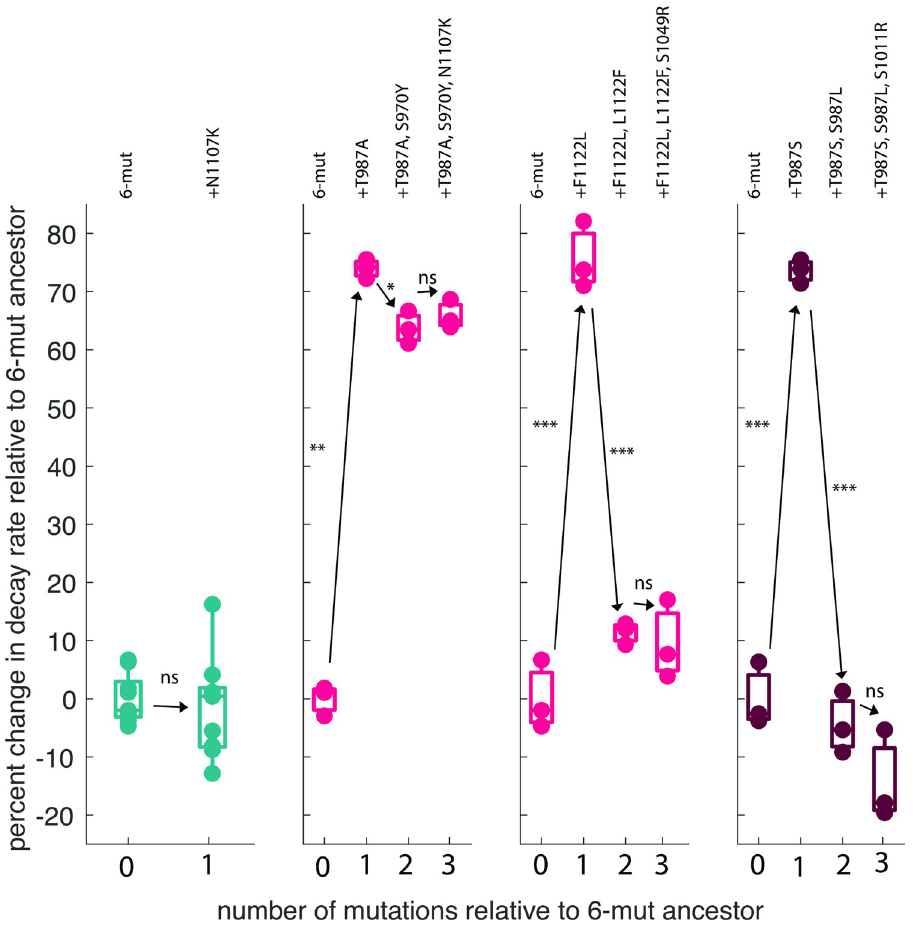
Fig 5. Trajectories of evolution of OmpF + in unmodified and stabilized backgrounds. Evolutionary trajectories of selected isolates from the replay experiment, reconstructed with genomic engineering. In the 6-mut (teal), a single mutation led to an OmpF + genotype. In three stabilized backgrounds (naturally evolved = red, engineered = dark red), an additional destabilizing mutation was required as a steppingstone to the OmpF + genotype. Asterisks along the lines indicate significant differences in decay rate between the genotypes connected by the line, as compared by paired t- tests corrected for multiple comparisons using the Bonferroni method. First panel: 6-mut vs. 6-mut N1107K: p = 0.678; Second panel: 6-mut vs. 6-mut T987A: p = 1.88x10 -6 ; 6 -mut T987A vs. 6-mut T987A S970Y: p = 0.0055; 6-mut T987A S970Y vs. 6-mut T987A S970Y N1107K: p = 0.3818; Third panel: 6-mut vs 6-mut F1122L: p = 9.25x10 -5 ; 6-mut F1122L vs. 6-mut F1122L L122F: p = 5.13x10 -5 ; 6-mut F1122L L122F vs. 6-mut F1122L L1122F S1049R: p = 0.667; Fourth panel: 6-mut vs. 6-mut T987S: p = 2.65x10 -5 ; 6-mut T987S vs. 6-mut T987S T987L: p = 1.83x10 -5 ; 6-mut T987S T987L vs. 6-mut T987S T987L S1011R: p = 0.143. (Bonferroni adjusted significance: � : p < 0.0167, �� : p < 0.00167, ��� : p < 0.000167, ���� : p <